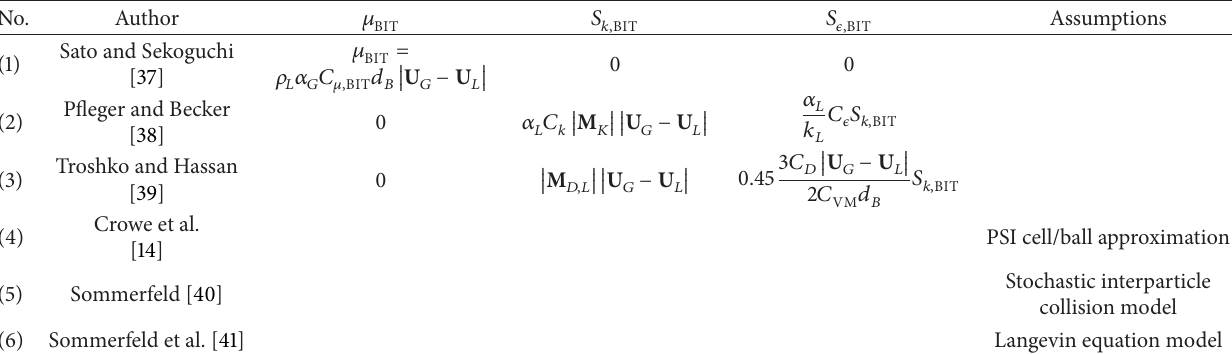
Table 2: Bubble-induced turbulence